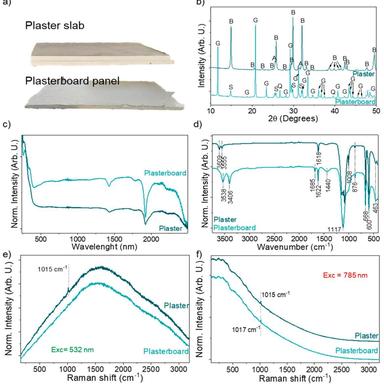
Gypsum-based material group (plaster and plasterboard) characterization composed by a) photographs, b) X-Ray diffraction patterns, c) FTIR, d) UV-SWIR, e) Raman spectra with 532 nm excitation source and f) Raman spectra with 785 nm excitation source. Legend: XRD: G: gypsum, B: bassanite, A: anhydrite, S: calcium sulphate and Q: quartz.